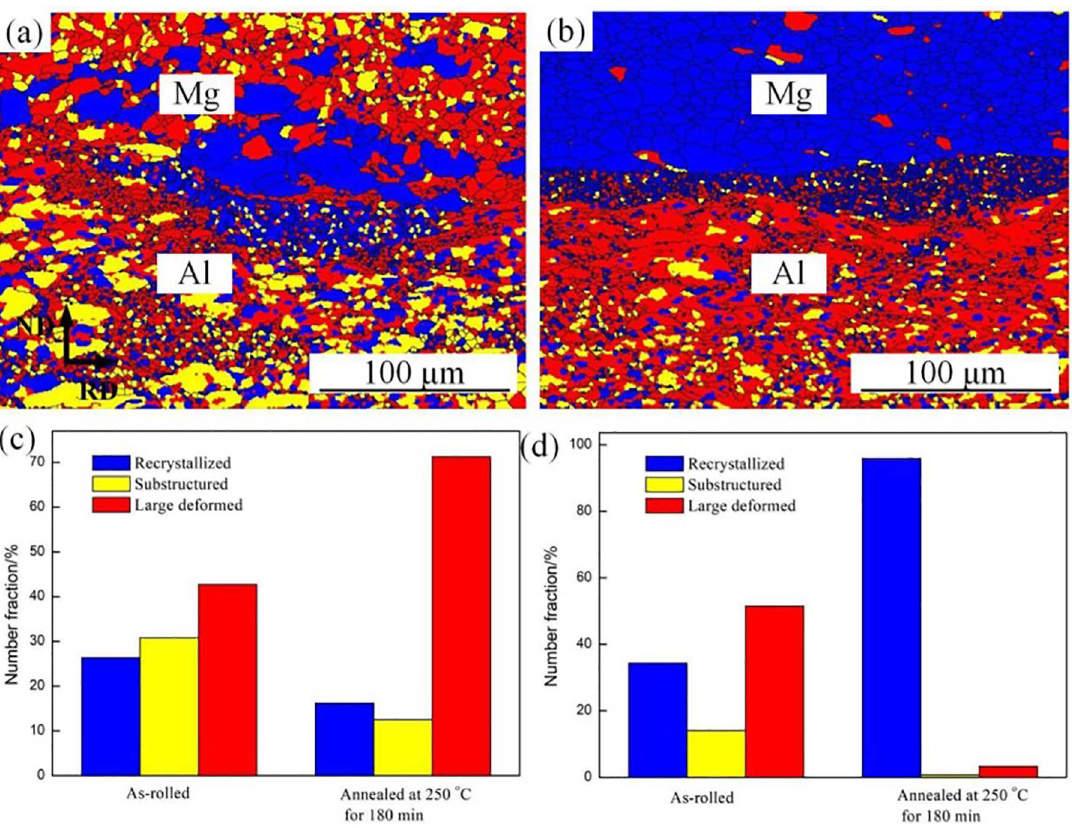
Figure 3. IPF of AZ31B/A356 composite plates (blue-recrystallized; yellow-substructured; red-large deformed): (a) as-rolled; (b) annealed at 250 ºC for 180 min; and the number fractions of recrystallized, substructured and large deformed grains in AZ31B/A356 composite plates: (c) A356 side; (d) AZ31B